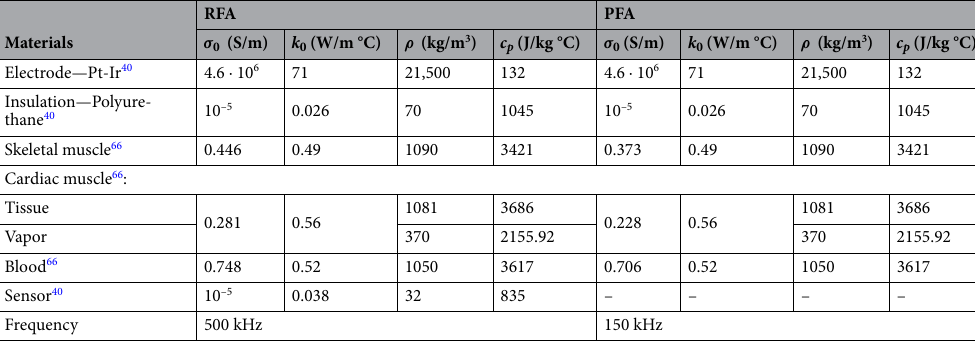
Table 4. Electrical and thermal properties of the materials used for RFA and PFA